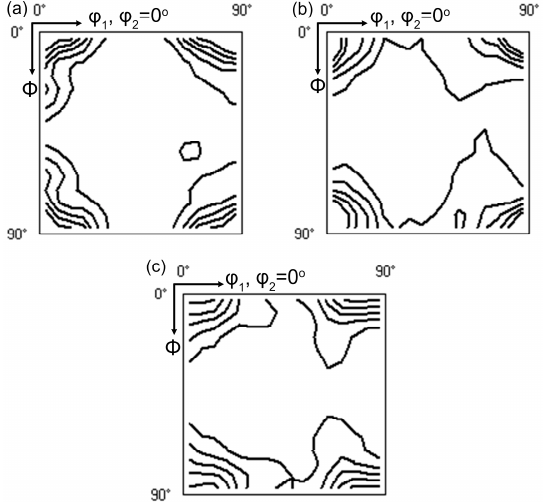
Figure 9. Texture of solutionized samples with different quenching rates: ( a ) 58.9 °C/s, ( b ) 7.0 °C/s, and ( c ) 1.9 °C/s.